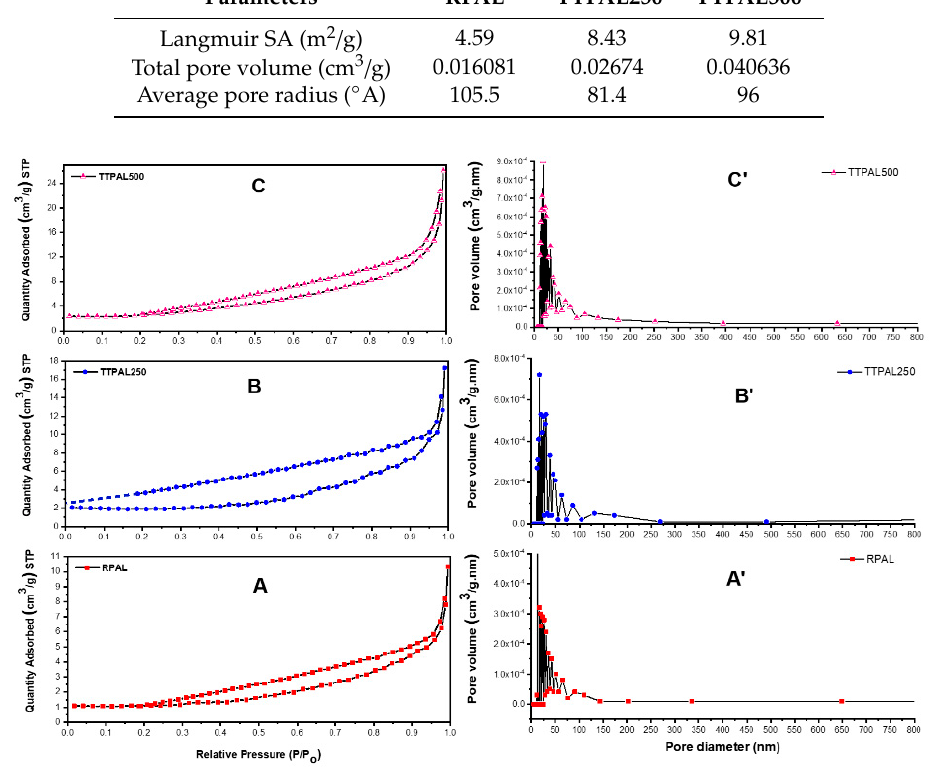
Figure 8. BET analysis of ( A ) RPAL, ( B ) TTPAL250, and ( C ) TTPAL500.